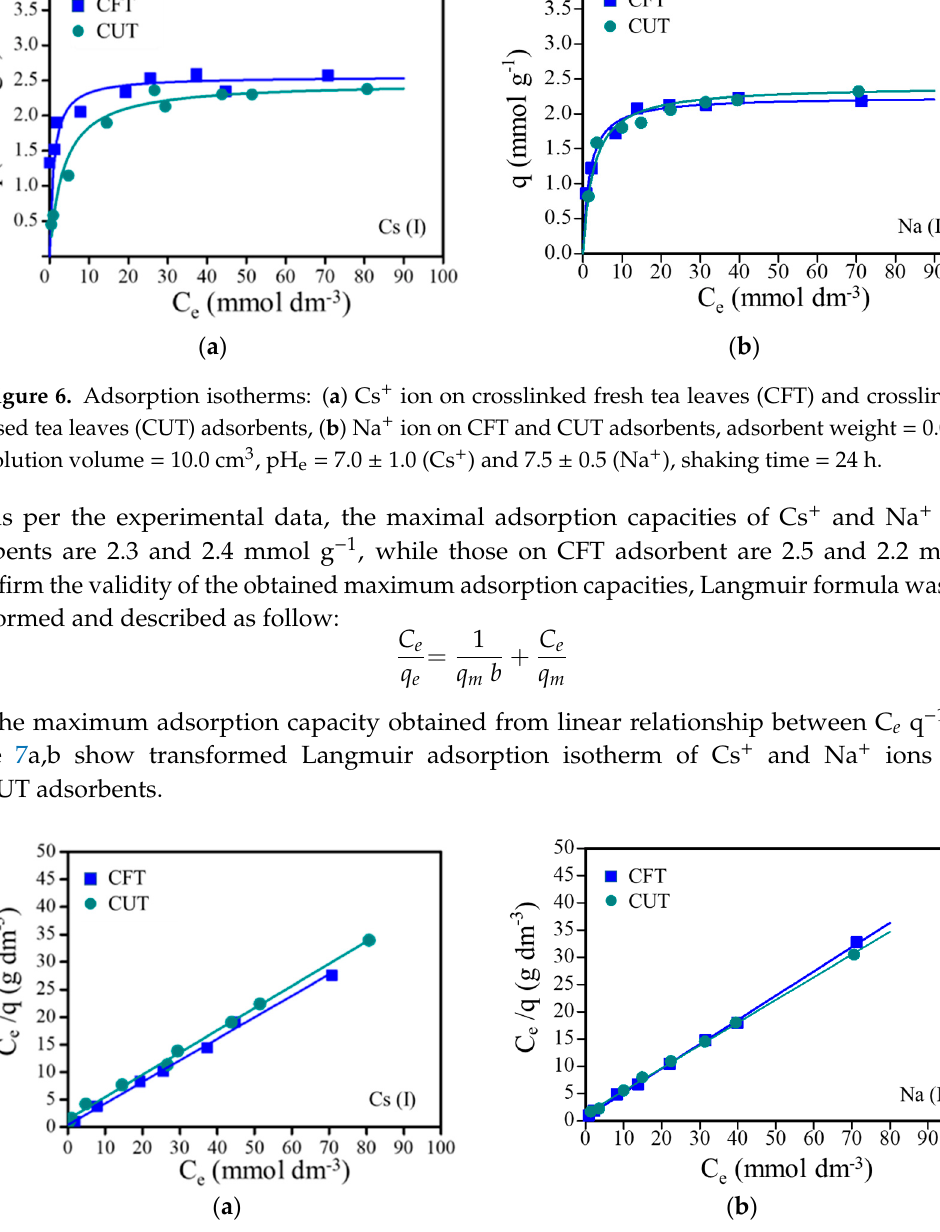
( b ) Figure 5. Effect of pH e value on distribution ratio of alkali metal ion at 303K, ( a ) crosslinked fresh tea leaves (CFT) adsorbents and ( b ) crosslinked used tea leaves (CUT) adsorbents, adsorbent weight = 0.05 g, solution volume = 10.0 cm 3 , [M + ] i = 1.0 mM each, shaking time = 24 h. 3.4. Adsorption Isotherms of Na + and Cs + Ions on CFT and CUT Adsorbents Naturally, the large existence of sodium ions leads to unavoidably the large amount of competitive ions containing in the polluted water. Hence, the adsorption isotherms for Na + and Cs + ion on CFT and CUT adsorbents at similar pH i (around 11) condition were investigated, as shown in Figure 6a,b, respectively. The adsorption amounts of adsorbents for Na + and Cs + ions increased with the increase of initial metal concentration and reached the maximum loading capacity. The results show that metal adsorption is classified into the Langmuir models [23]: